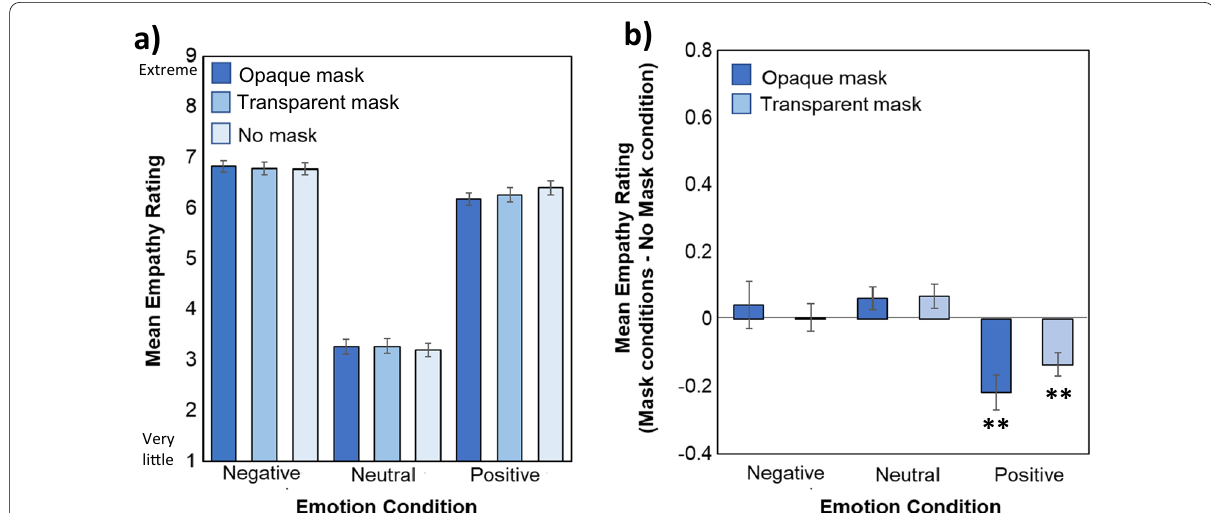
Fig. 4 a Ratings of empathy for the protagonist during each Emotion and Mask condition on a scale from 1/very little to 9/extreme. b Comparison of empathy ratings for protagonists wearing opaque and transparent masks relative to those with no masks for each Emotion condition (calculated by subtracting the no mask condition from each mask condition). Bigger bars indicate a bigger difference from the No mask condition, with ** indicating a significant difference from the no mask condition at p < .01. Error bars represent standard error of the